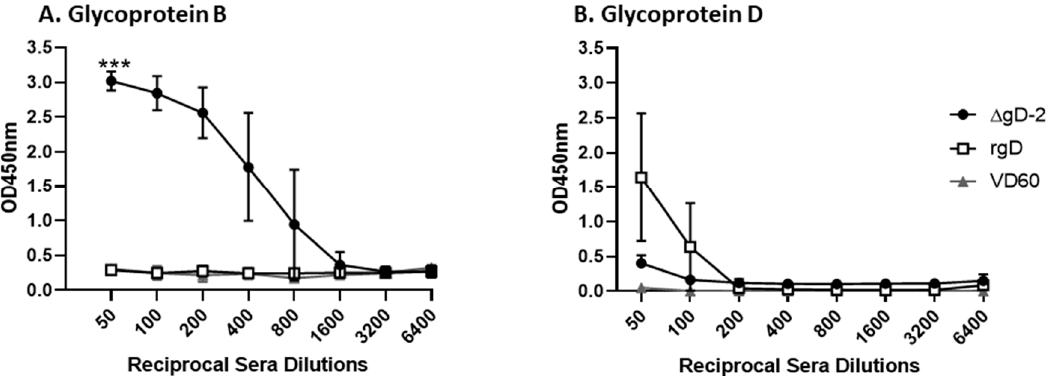
Figure 2. C1q binding of immune serum to glycoproteins gB or gD. Serial 2-fold dilutions of heat-inactivated immune sera (1:50–1:6400) were assayed for ability to bind C1q in ELISA with ( A ) recombinant gB or ( B ) recombinant gD protein. Results are shown as mean ± SD of the optical density units at each dilution ( n = 10 mice per group) and the area under the curve was compared to VD60 controls by unpaired t -test with Welch’s correction (*** p < 0.001).